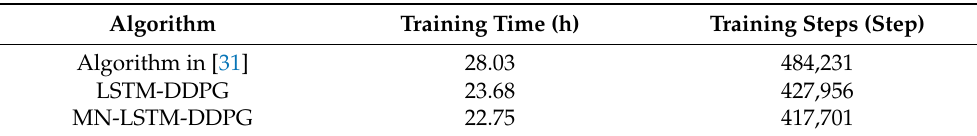
Table 1. Comparison of training time and steps of the improved algorithm in simulation Figure 6a.